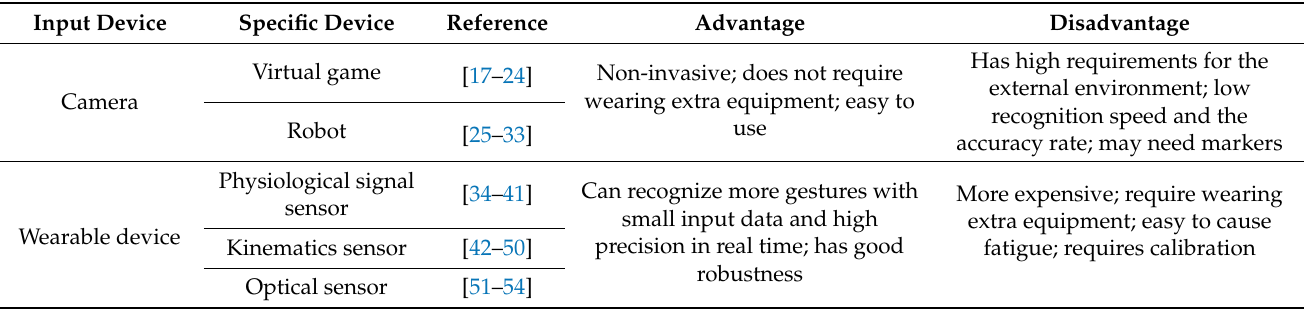
Table 1. This table is a summary of the different input device for the hand function rehabilitation system and indicates the main advantages and disadvantages of these